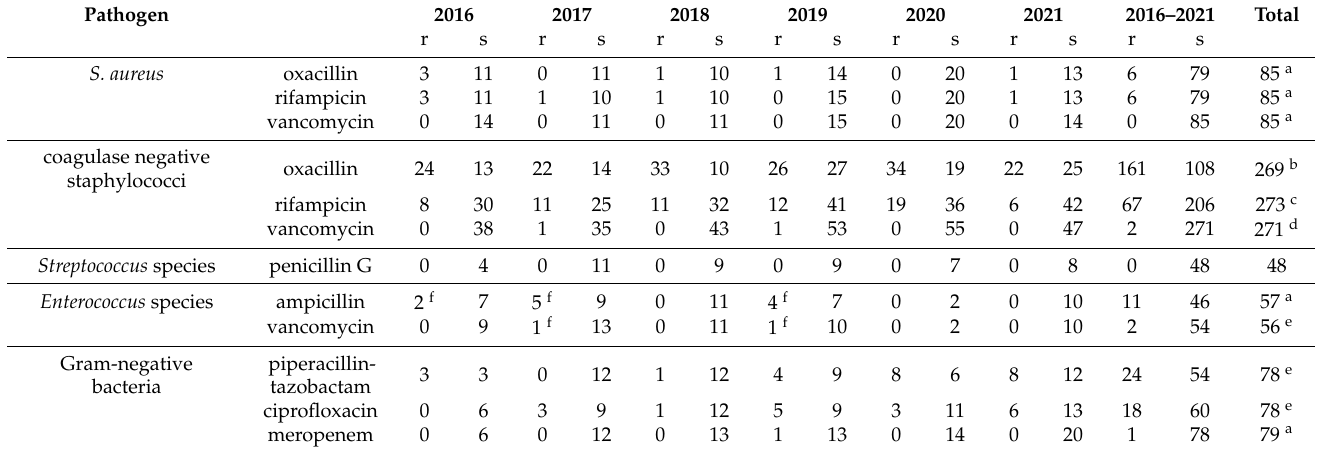
Table 3. Antibiotic resistance of selected pathogens against selected